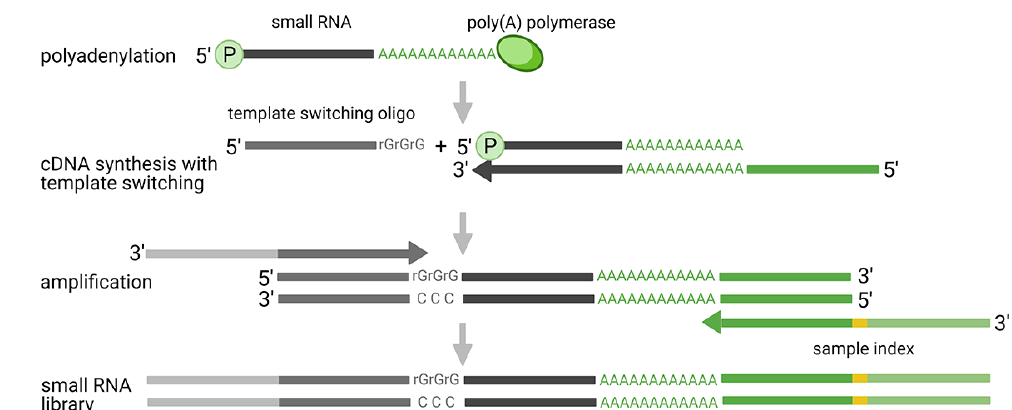
Figure 3. Polyadenylation and template switching mechanism applied in small RNA-seq